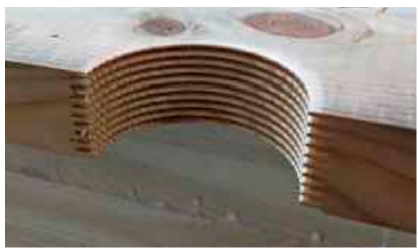
Figure 3. Appearance of the socket and the insert used to fill in the space left by an edge knot.